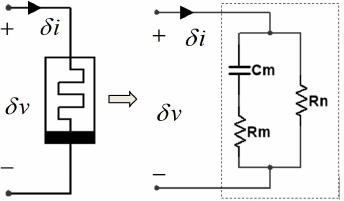
Figure 10. The schematic diagram of one novel small-signal equivalent circuit.